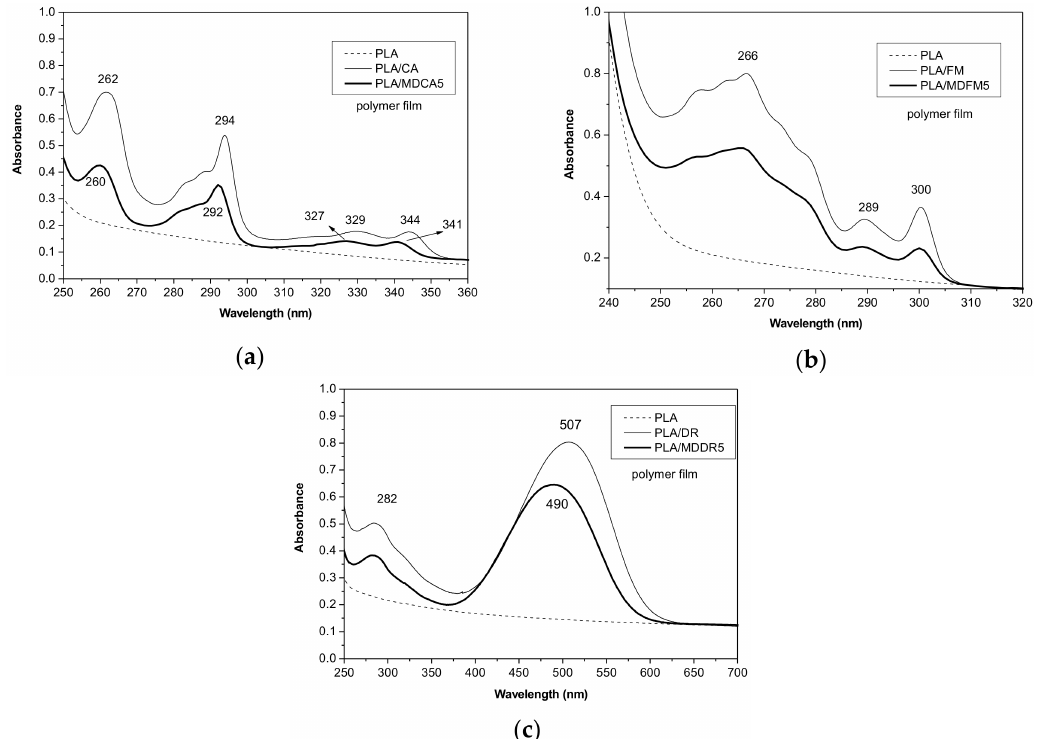
Figure 7. UV-vis absorption spectra were collected from polymeric film: ( a ) poly(lactic acid) (PLA), PLA mixed with CA (PLA / CA), and PLA mixed with MDCA5 (PLA / MDCA5); ( b ) PLA, PLA mixed with FM (PLA / FM), and PLA mixed with MDFM5 (PLA / MDFM5); and ( c ) PLA, PLA mixed with DR (PLA / DR), and PLA mixed with MDDR5 (PLA /